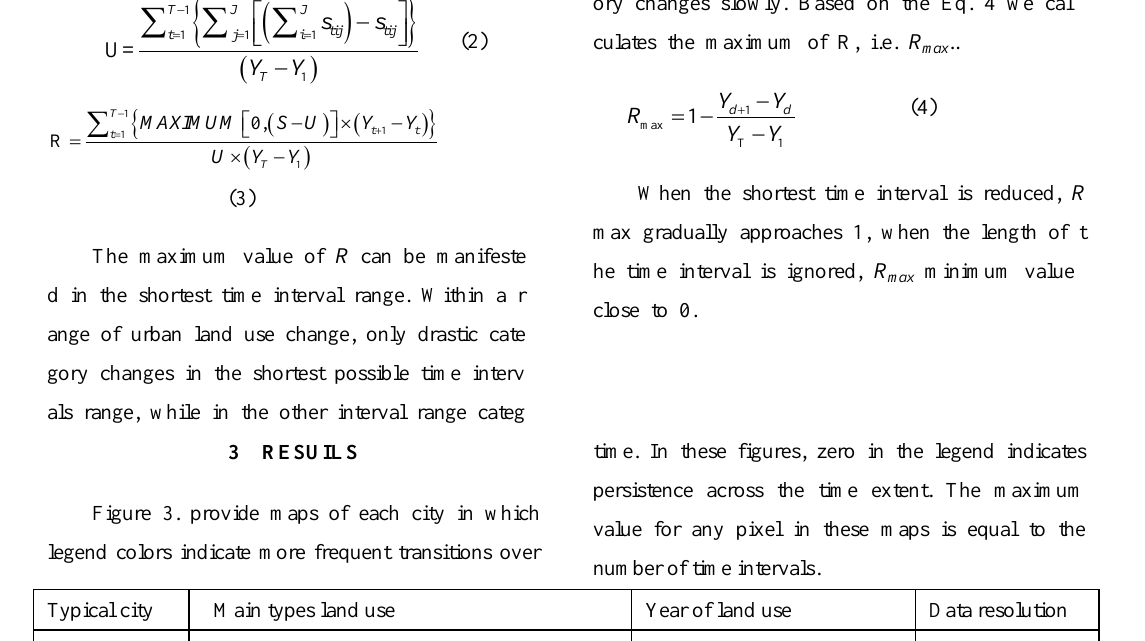
Figure 3. provide maps of each city in which legend colors indicate more frequent transitions over